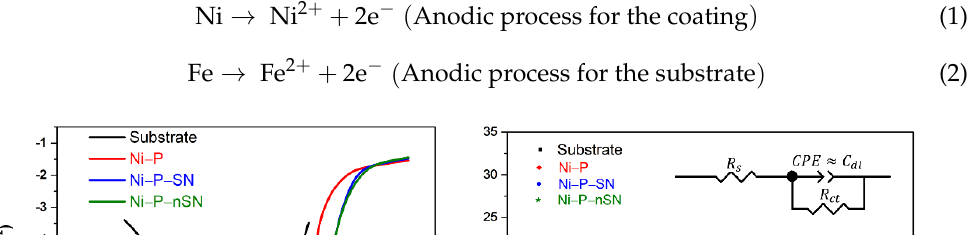
methods are presented in Table 1. The 𝐸 (cid:3030)(cid:3042)(cid:3045)(cid:3045) of the low-carbon steel substrate is in the negative potential region ( − 0.260 V). All the coated specimens have higher 𝐸 (cid:3030)(cid:3042)(cid:3045)(cid:3045) value in